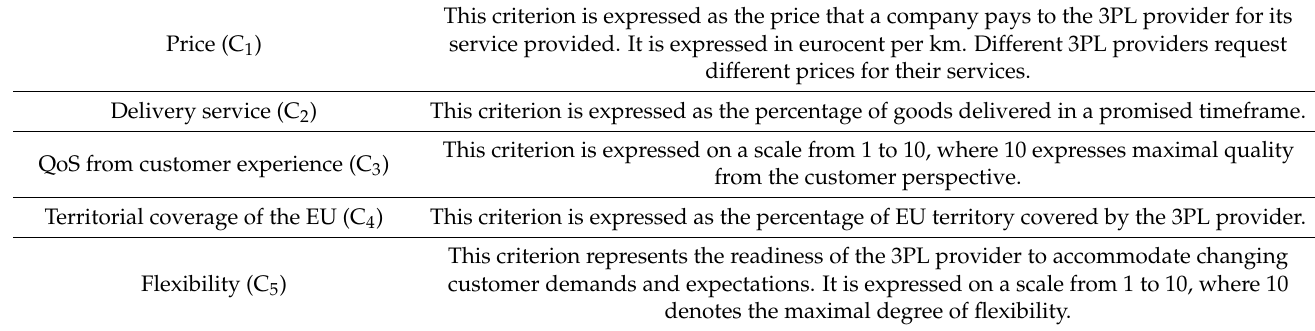
Table 2. Criteria for 3PL evaluation and selection (Source: Authors).